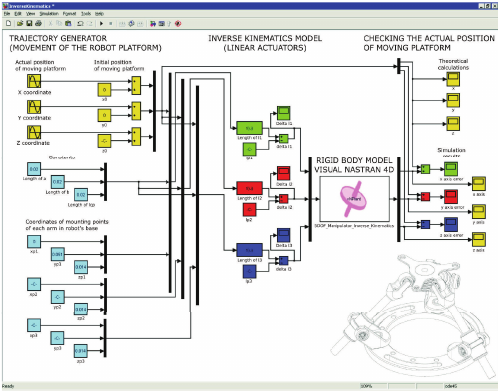
Figure 10: Computational model developed in MATLAB/Simulink.